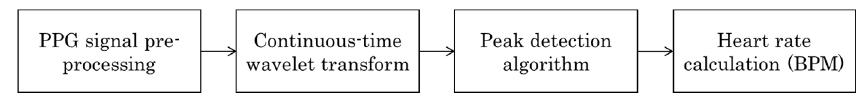
Figure 4. Block diagram showing the main processing steps to extract pig ′ s heart rate from PPG signal.